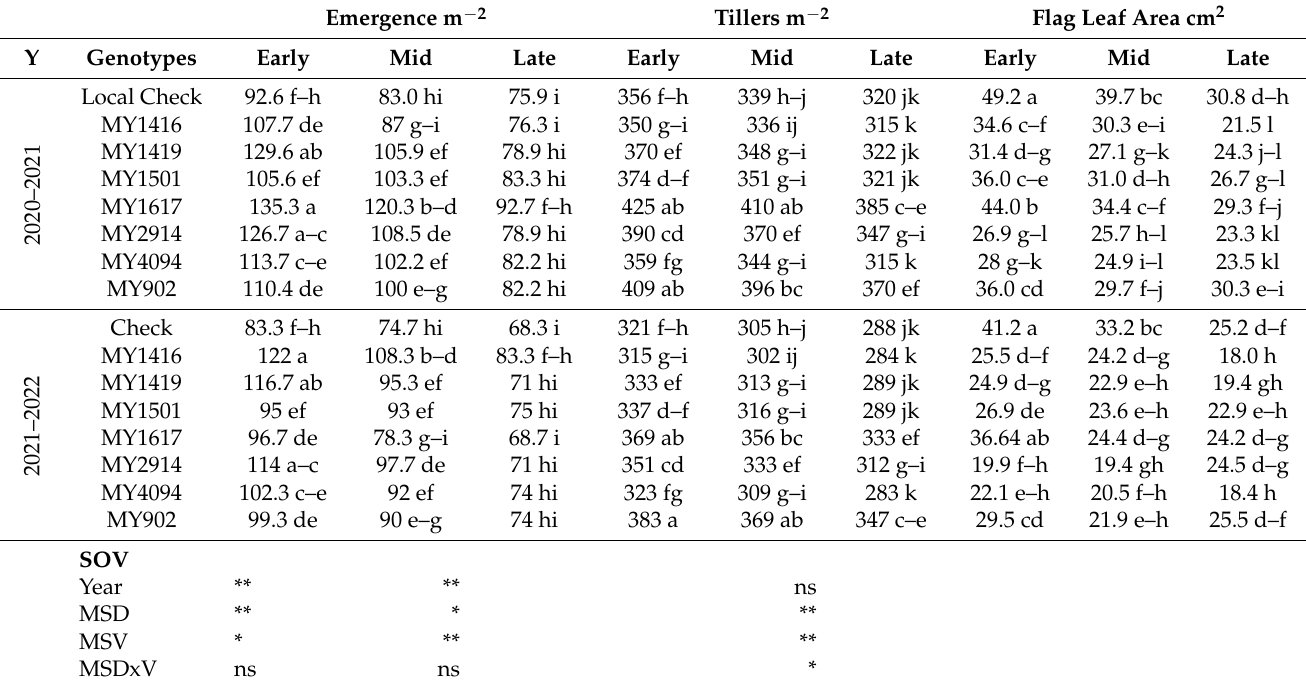
Table 4. Emergence m − 2 , tillers m − 2 , and flag leaf area of different wheat genotypes grown under the semi-arid climate of northern Pakistan.